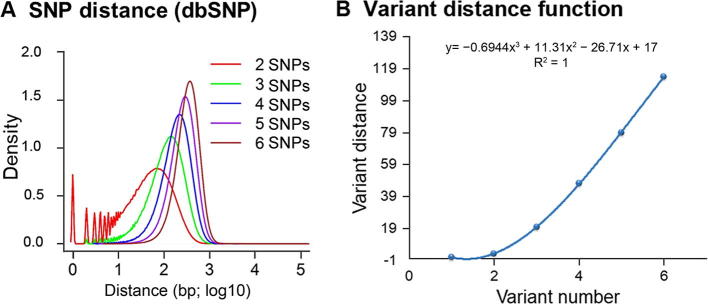
The evaluation of sequence error and variant A. Density plot of the distance between adjacent variants (bp) in dbSNP was used to set up the variant distance. Numbers before “SNPs” in the legend box indicate the numbers of consecutive SNP loci. B. Trinomial function (y = −0.6944x3 + 11.31x2 − 26.71x + 17; x and y indicate the variant number and variant distance, respectively) is used to filter reads based on read mismatch, insertion, and deletion to distinguish the true SNPs and sequencing errors.